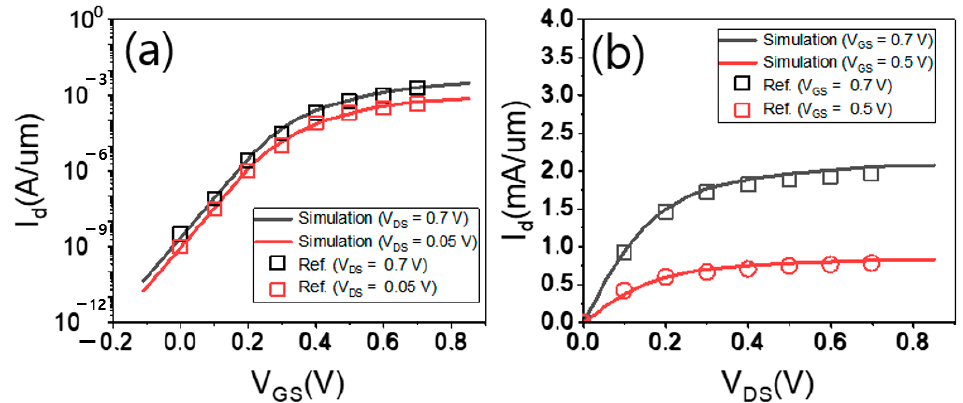
Figure 4. ( a ) Input and ( b ) output transfer characteristics of FinFET (which were calibrated to the measured data reported in [1]).